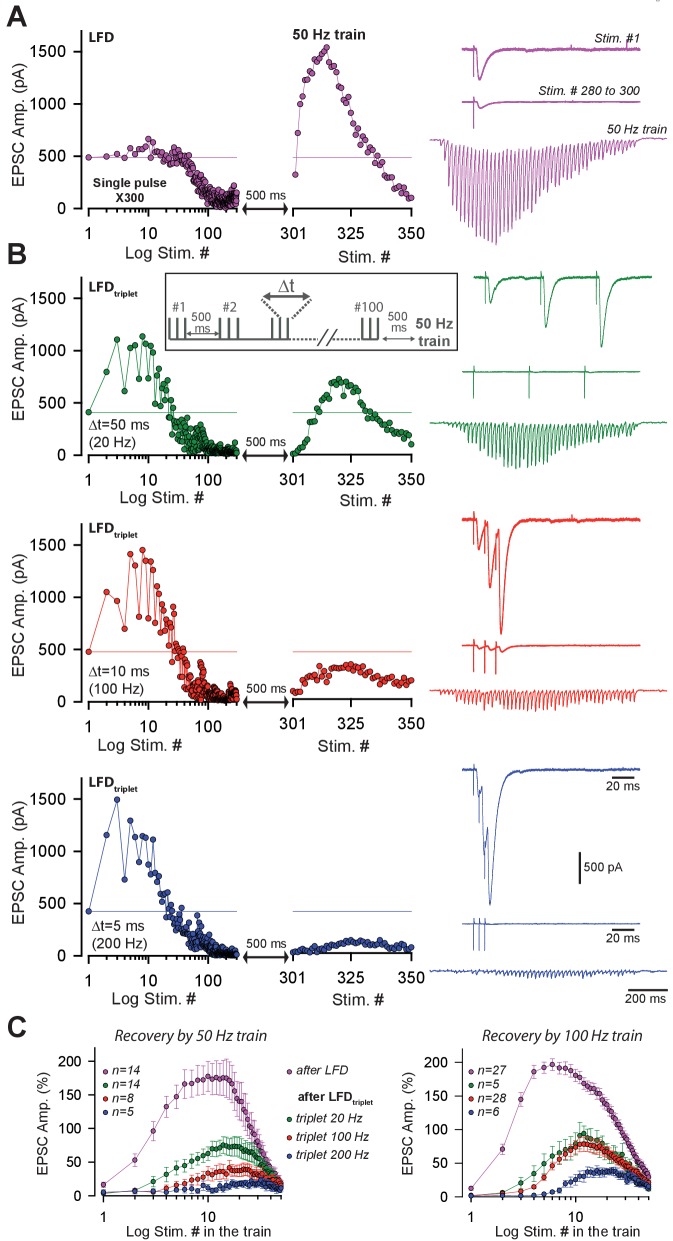
Short-term facilitation during triple-pulse stimulation at high frequency impedes recovery from LFD via high-frequency trains.(A) Left panels an example of EPSC amplitudes during LFD followed by a 50 Hz train of stimulation. Right panel, upper trace, EPSCs elicited by the first stimulation at 2 Hz, middle traces, averaged EPSCs recorded during the LFD plateau (stimuli #280 to #300), bottom traces, EPSC recorded during the 50 Hz train applied 500 ms after the 2 Hz stimulation (artifacts subtracted). (B) left panels, time courses of EPSC amplitudes induced by triples pulse at different frequencies (LFDtriplet, see inset for protocol) as indicated and by a subsequent 50 Hz train. Right panel, upper trace, EPSCs elicited by the first triplet at 2 Hz, middle traces, averaged EPSCs recorded during the LFD plateau (stimuli #80 to #100), bottom traces, EPSC recorded during the 50 Hz train applied 500 ms after the 2 Hz stimulation (artifacts subtracted). For A and B, all data and traces were obtained in the same PC, and LFDs or LFDstriplet were elicited after a resting period of 5 min after the end of each protocol. (C) Mean values of normalized EPSC amplitudes evoked by 50 Hz train (left) and 100 Hz train (right) applied 500 ms after LFD induction (300 single stimuli at 2 Hz or 100 triple pulses at 2 Hz). Same color code than in A and B.